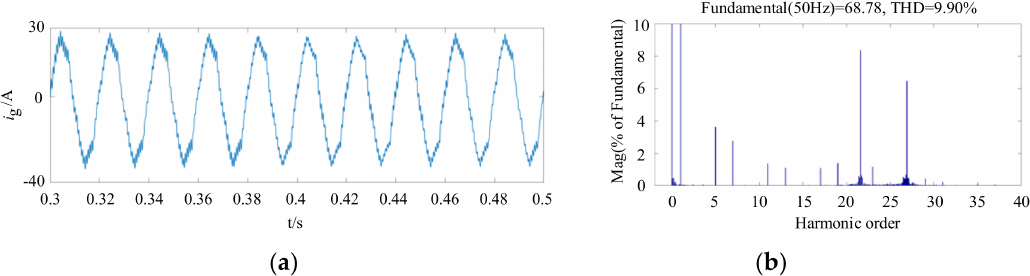
Figure 13. ( a ) Grid-connected current waveform; ( b ) Grid-connected current harmonic